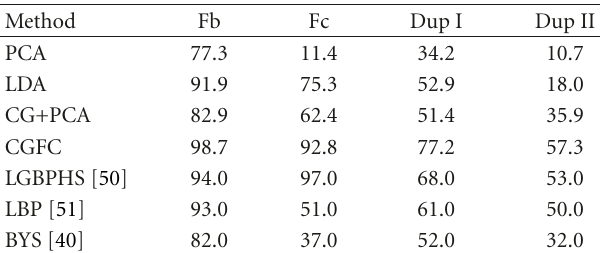
Figure 25: CMC curves for the challenging All probe set of the AR database. Table 5: Rank one recognition rates (in %) obtained on di ff erent probe sets of the FERET database.